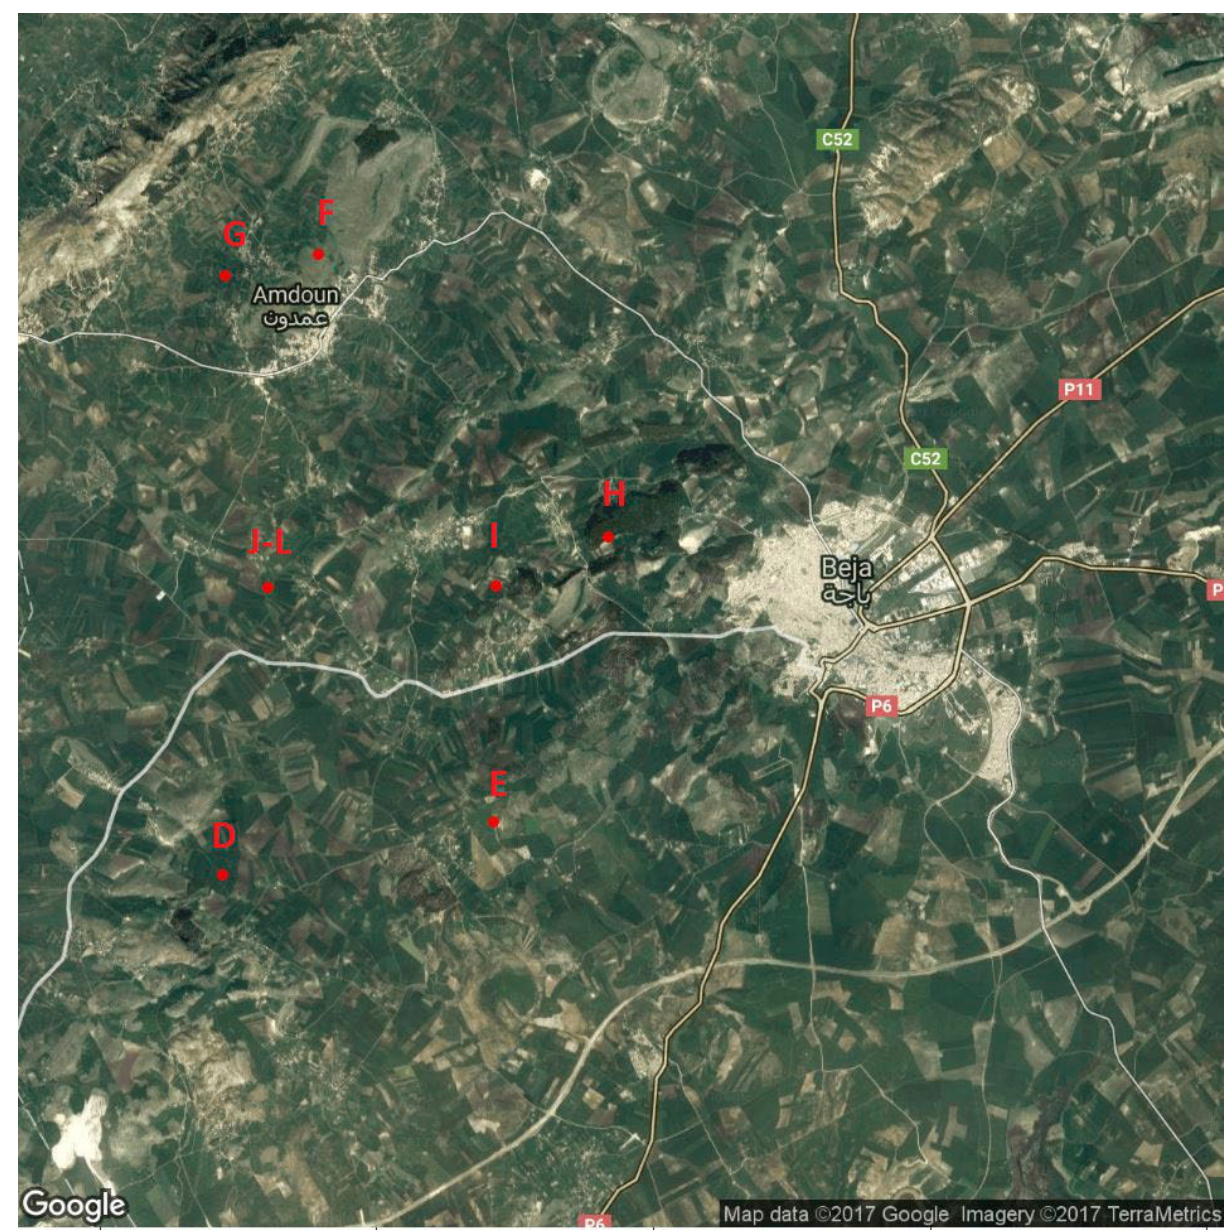
Figure 1 . Locations where sunflower broomrape populations were collected. Letters D to L represent populations ORD to